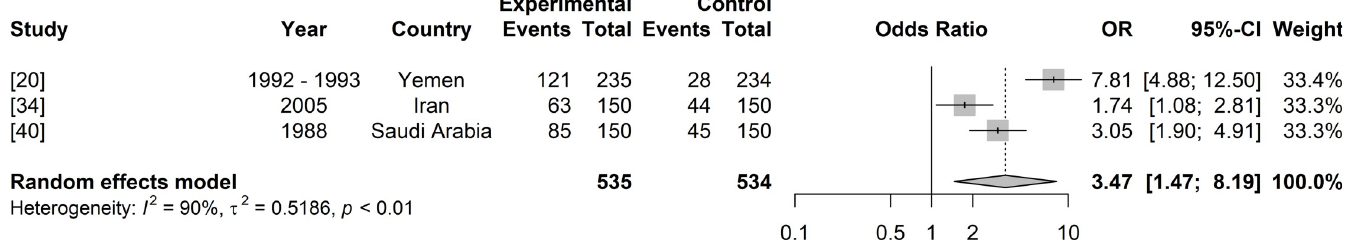
Fig 4. Forest plot of odds ratio for brucellosis among risk work groups (animal breeders, farmers, abattoir workers and laboratory workers) exposed and other individuals not occupationally exposed to Brucella spp. during their labor activities. Year indicates the period in which study was performed.